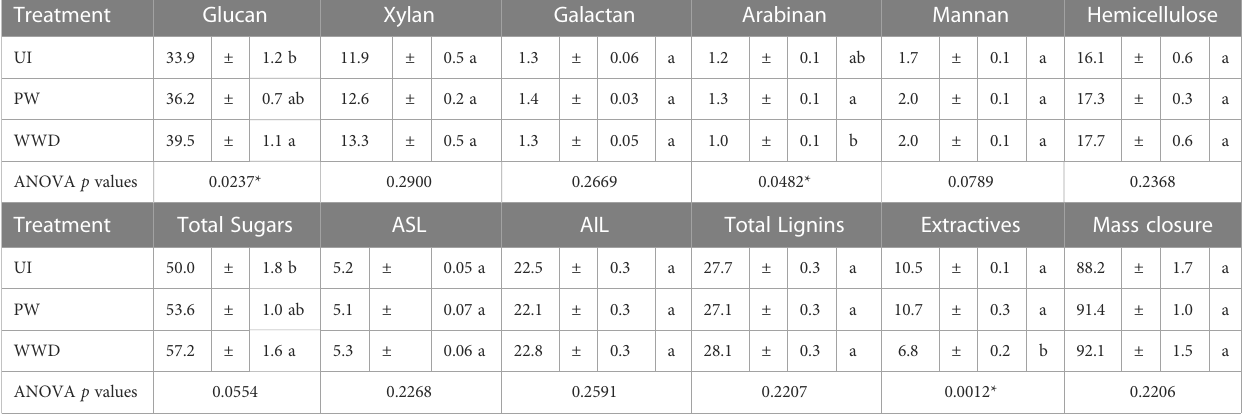
TABLE 5 Wood composition analysis of Salix miyabeana SX67 plants under different irrigation treatments. Treatment